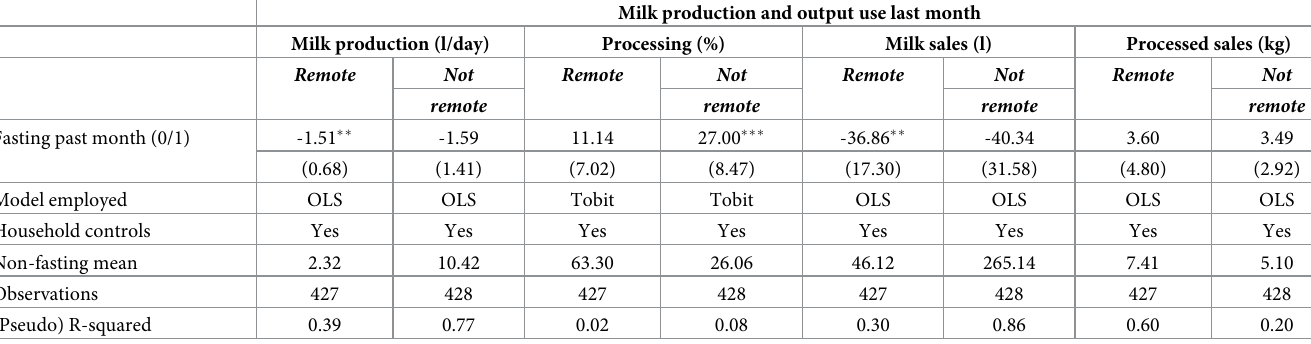
Table 9. Heterogeneity in milk production and output use adaptation strategies by remoteness to Addis Ababa. Milk production and output use last